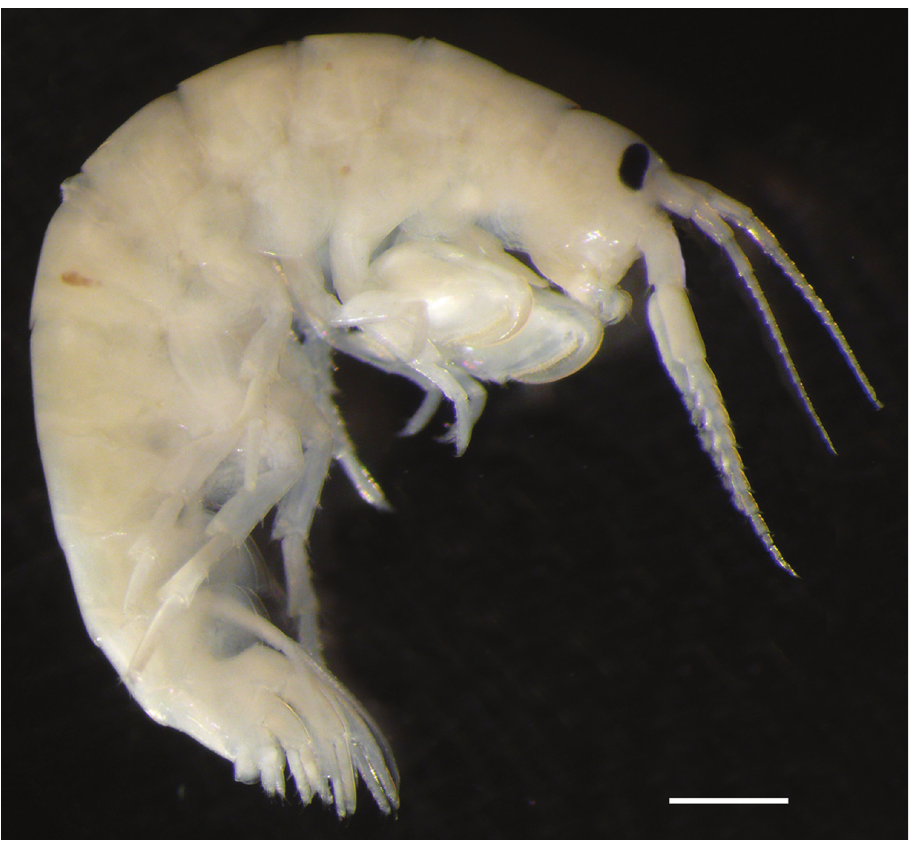
Figure 2. Male of Ptilohyale littoralis , sampled in October 2015, from Bay of Arcachon, France. Scale bar 1